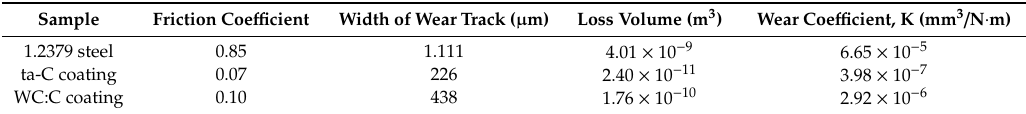
Table 3. Summary of the experimental data on the friction coe ffi cient, width of wear track, loss volume,